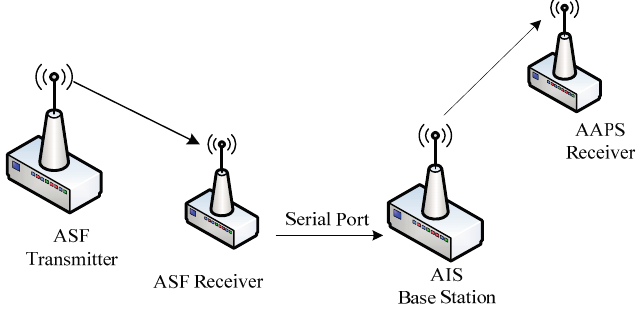
Figure 9. Connection diagram between the ASF correction system and